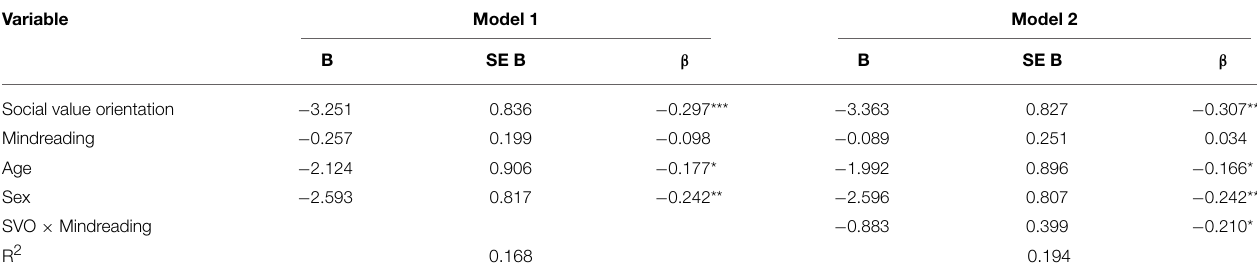
TABLE 2 | Summary of regression analysis for variables predicting trust without interaction term (Model 1) and with interaction term (Model 2). Variable